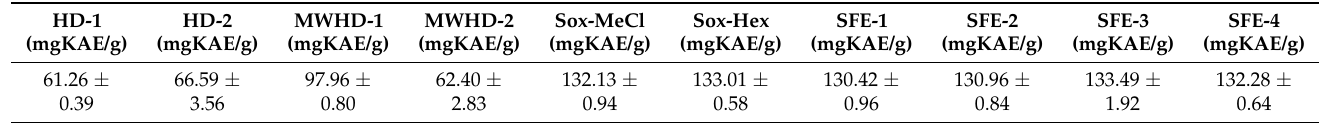
Table 2. Inhibition of tyrosinase by chamomile essential oils and extracts obtained by various distillation and extraction techniques.